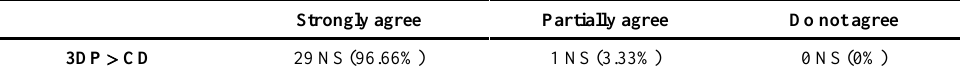
Table 3. 3DP enhances spatial cognition more than CD (Students agreement).